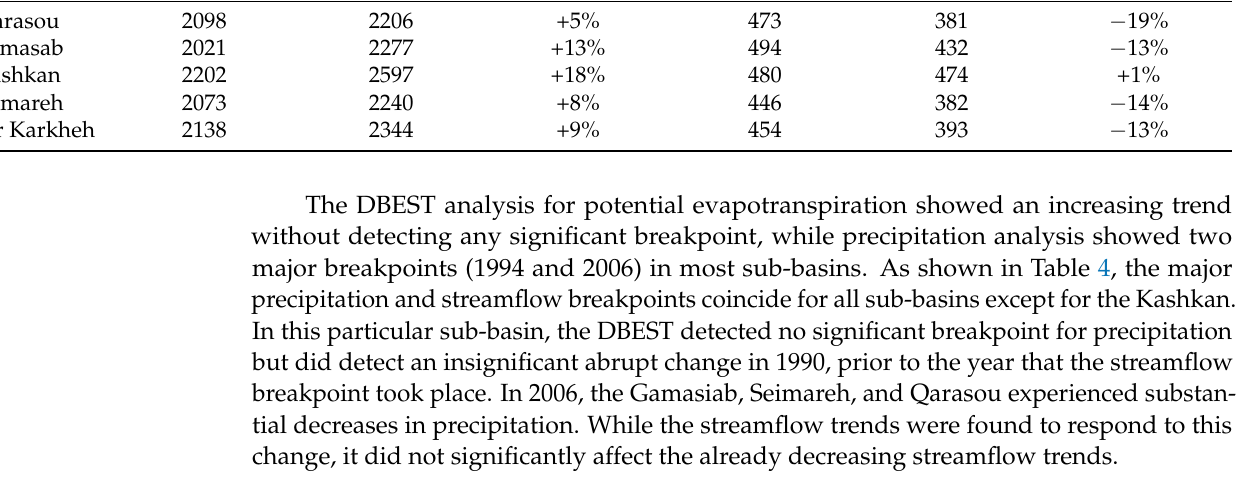
Table 4. Precipitation trend analysis and the DBEST-detected breakpoints in the KRB.